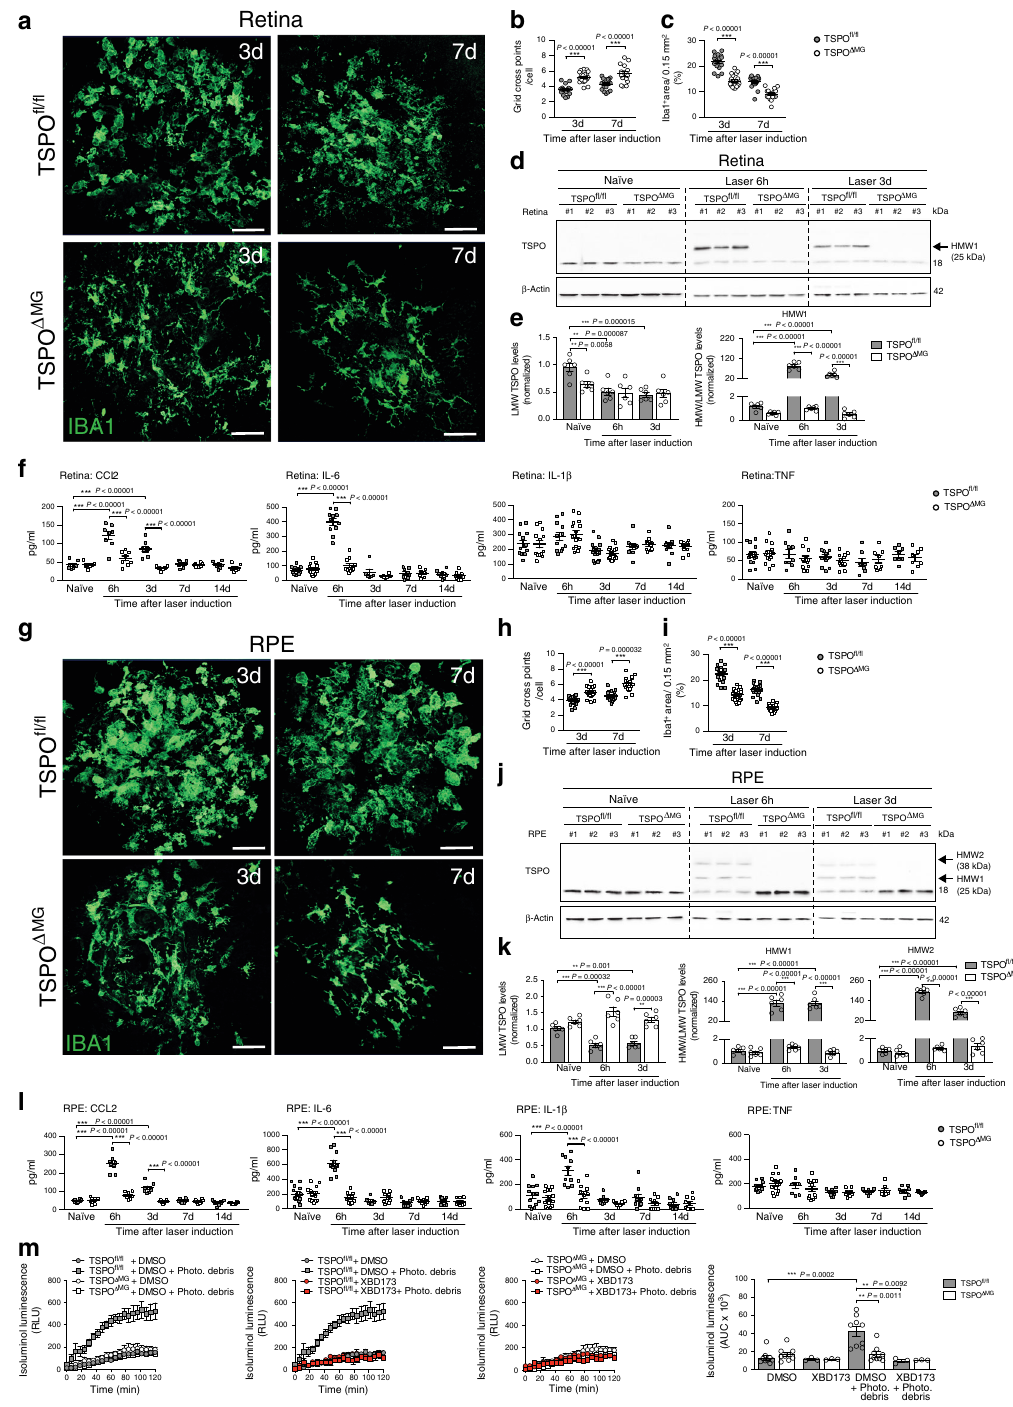
simultaneous detection of Aif/Ang1 (Supplementary Fig. 7c, d) and Aif/Ang2 (Supplementary Fig. 7e, f). These results indicate that Iba1 + mononuclear phagocytes from TSPO fl / fl and TSPO Δ MG mice express Vegf , Ang1 , and Ang2 mRNA after